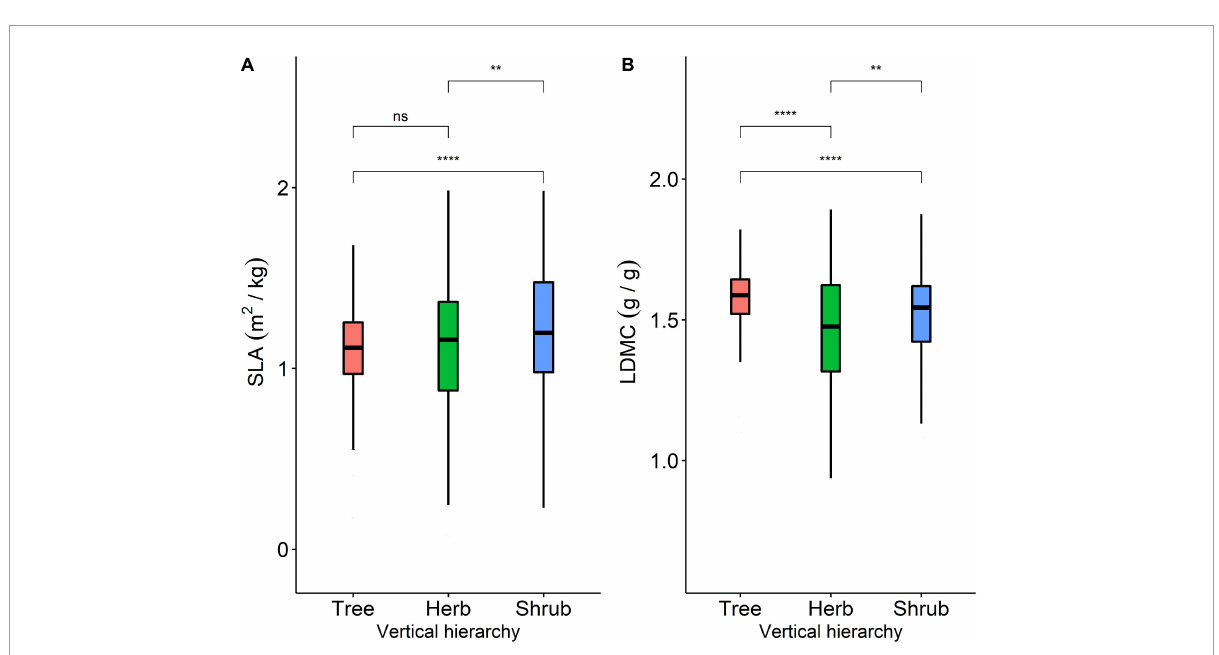
FIGURE2 (A) Variability of SLA among trees, shrubs, and herbs; (B) variability of LDMC among trees, shrubs, and herbs. **Represents P < 0.01, ****represents P <